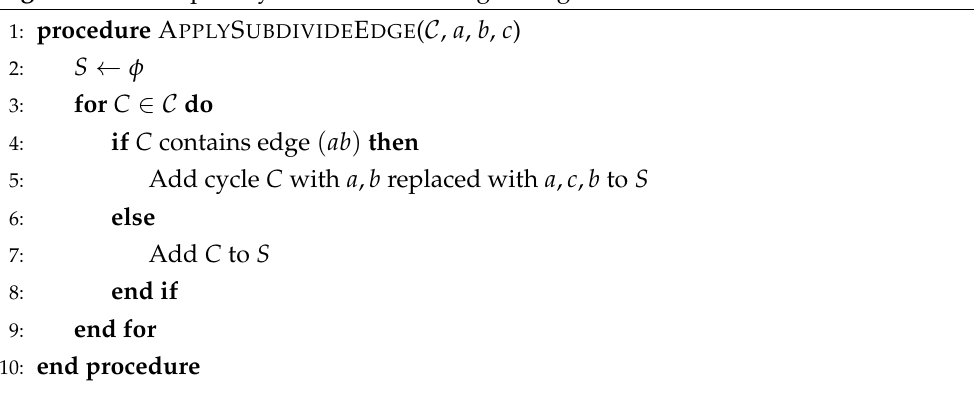
Algorithm 2 Compute cycles for subdividing an